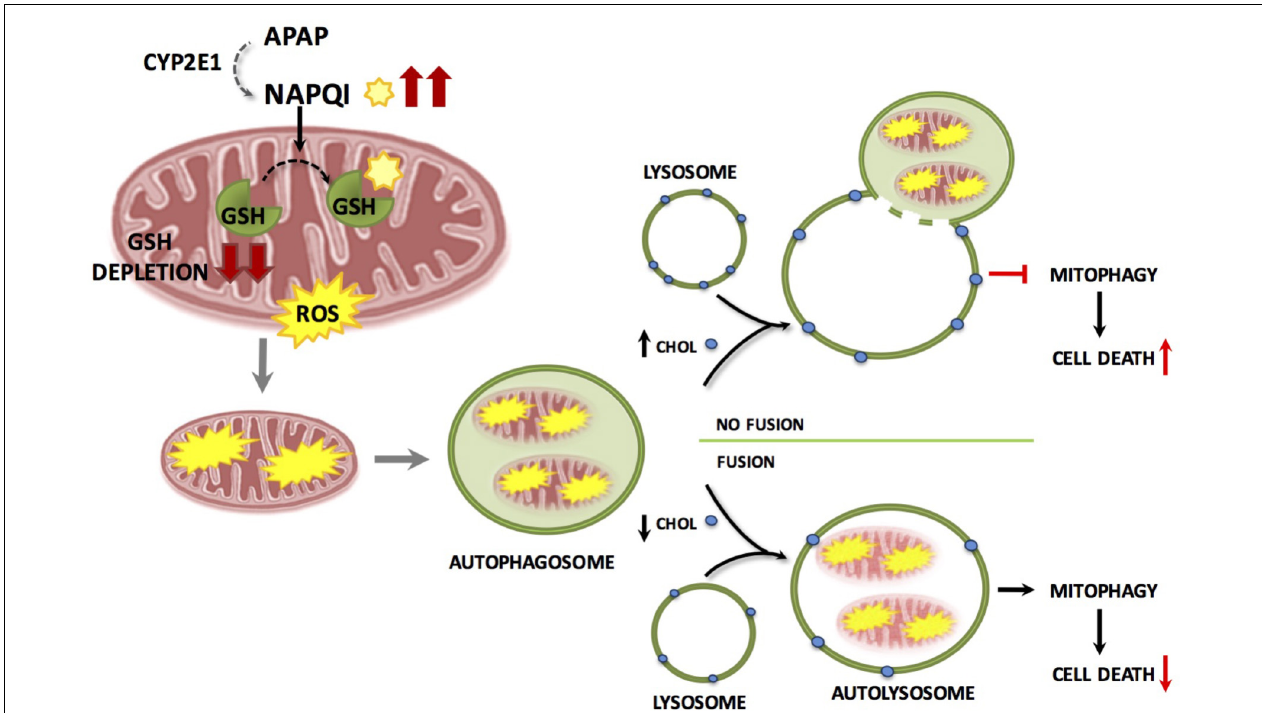
FIGURE 4 | Accumulation of lysosomal cholesterol impairs mitophagy resulting in increased hepatocyte cell death and liver injury during APAP-induced liver injury. APAP metabolism and NAPQI generation and GSH depletion are independent of lysosomal cholesterol content and cause mitochondrial damage and dysfunction. Damaged mitochondria are engulfed by autophagosomes which fuse with lysosomes clearing dysfunctional mitochondria through mitophagy resulting in a decrease in hepatocyte cell death. Accumulation of cholesterol in the lysosomal membrane results in impaired autophagosome/lysosome fusion resulting in defective mitophagy and increased hepatocyte cell